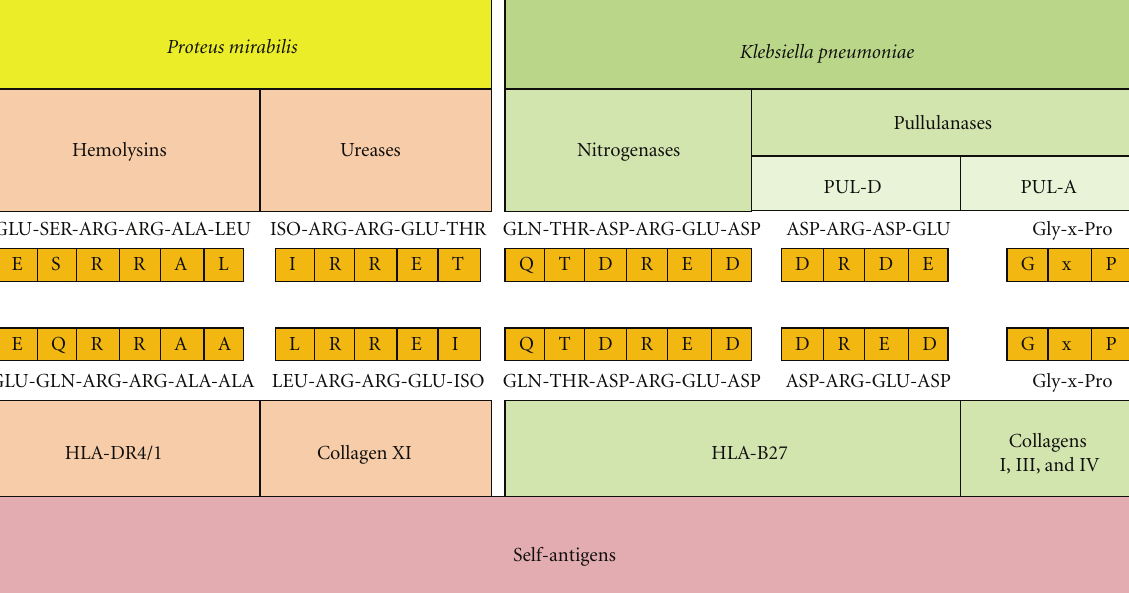
a similarity which involves repeated molecular motifs, consisting of glycine-x-proline (Gly-x-Pro) amino acid sequences present in both Klebsiella pullulanase Pul-A secretion proteins and collagen type I, III, and IV fibres (Figure 1)